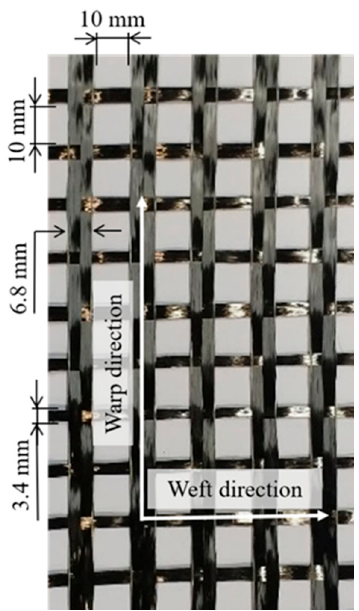
Figure 1. Geometrical properties of the carbon fiber mesh used as textile reinforcement.